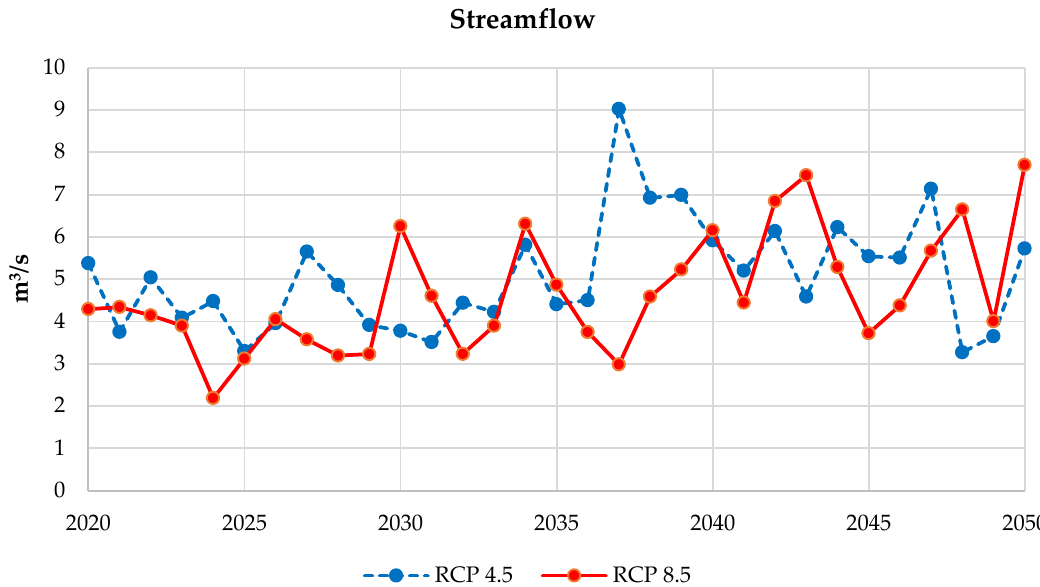
Figure 5. The observed vs. simulated runoff in the ( a ) Kauter and ( b ) Beytas Rivers.